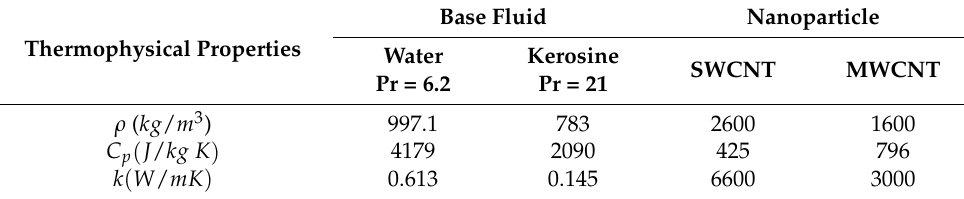
Table 2. Thermophysical properties of nanoparticle, nanoparticle, and base fluid [15,21].